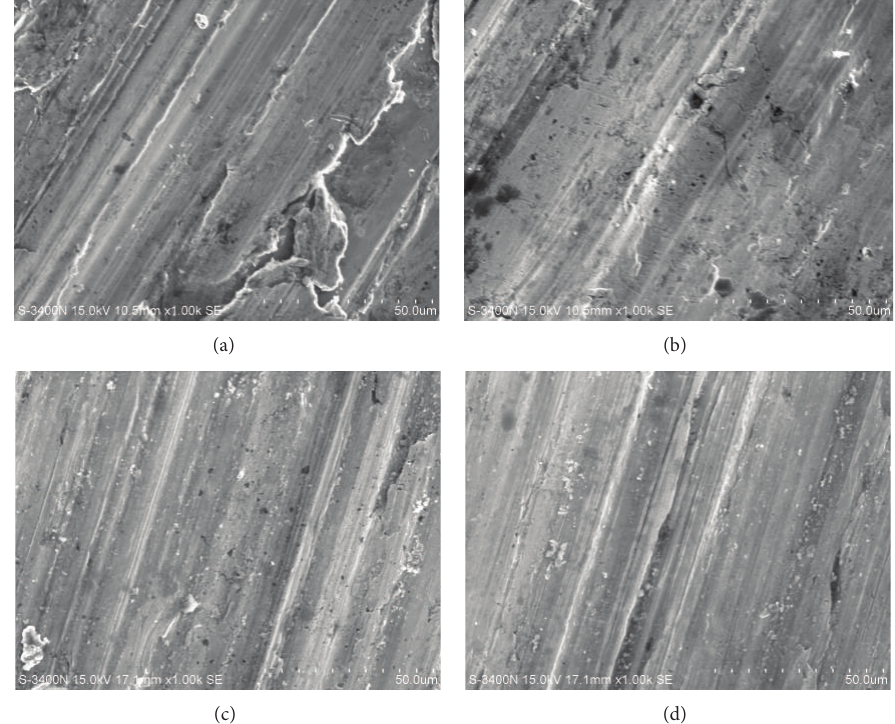
Figure 17: SEM micrograph (1000 × ) of wear track for coated magnesium (Mg) composite reinforced with multiwall carbon nanotube (MWCNT) at various Al 2 O 3 (a) 0.1% (b) 0.5% (c) 1% (d) 2%.